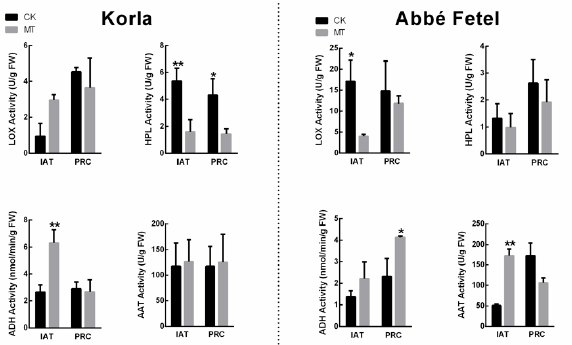
Figure 4. Effect of melatonin on LOX, HPL, ADH, and AAT activity. Data are means ± SE of three replicates. * p < 0.05, ** p < 0.01.